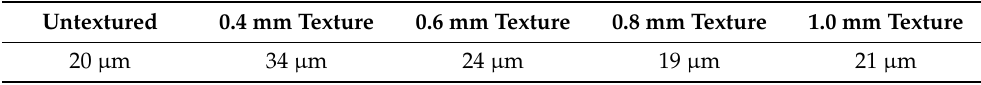
Table 6. Maximum wear depth of disc test piece at 15 mm.